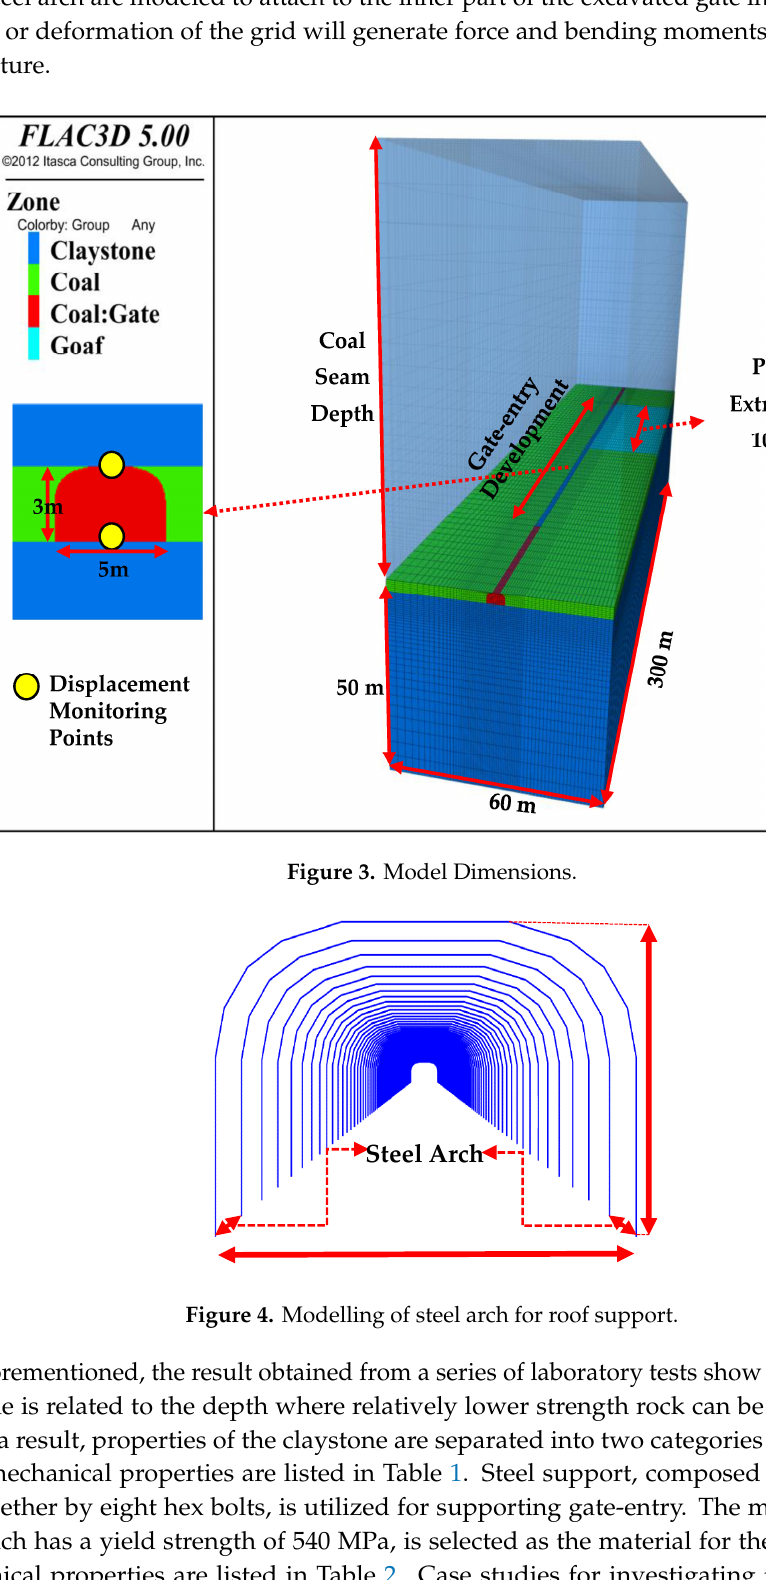
Figure 5. Study Case of Remaining Coal Thickness.